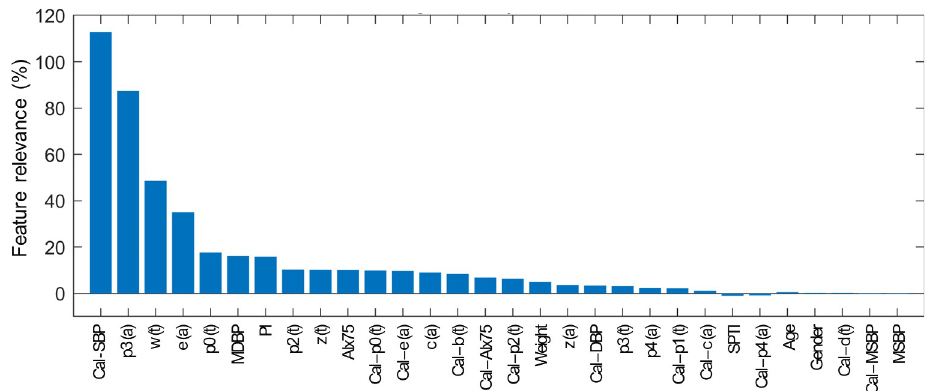
Fig 3. Feature relevance scores for SBP estimation model with a calibration PPG-BP measure. Features from the calibration segment are indicated by the prefix cal. The reference value obtained the highest relevance. The following were PWA-derived features from the PPG waveform, as well as time (t) and amplitude (a) of characteristic points from its derivatives (VPG, APG and JPG). Personal information, such as weight, obtained a low relevance score. The results were alike for DBP.